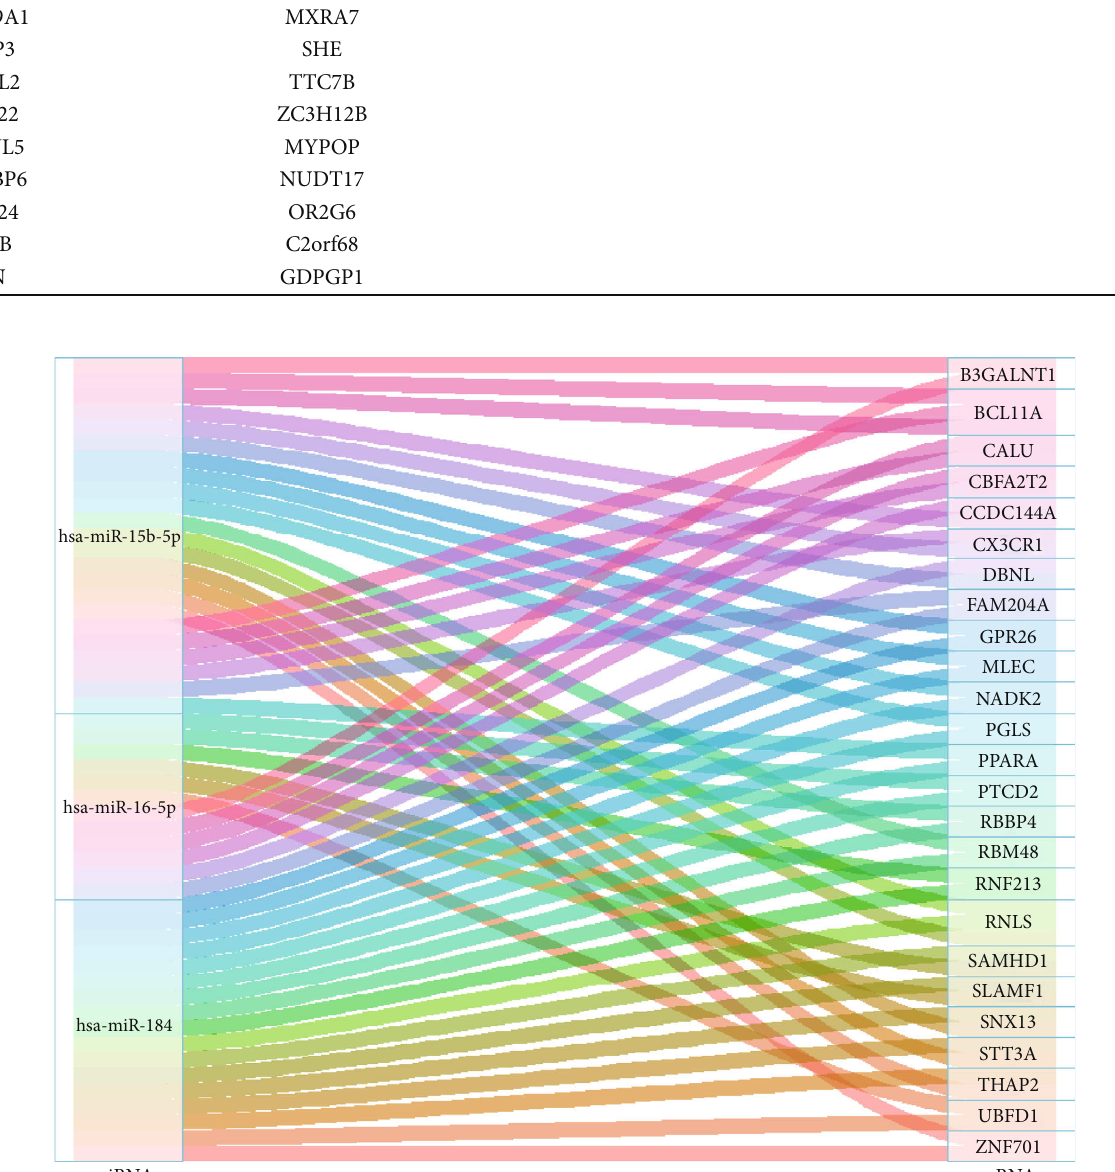
Figure 3: Sankey diagram of the miRNA-mRNA Network in